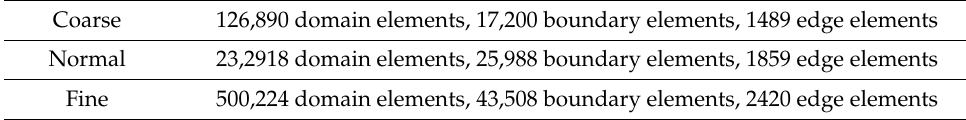
Table 1. Mesh information for different levels of